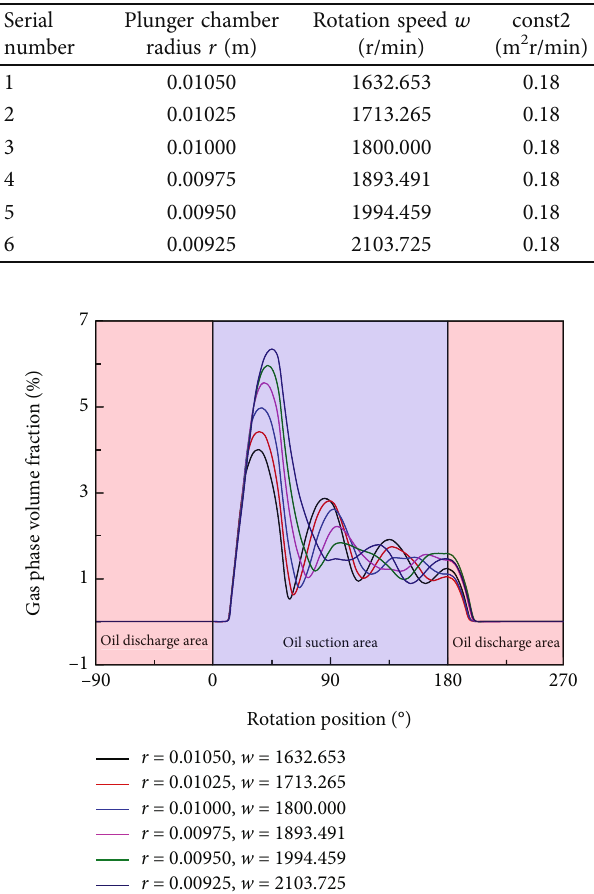
Figure 17: The curves of the gas phase volume fraction in the plunger chamber with di ff erent plunger chamber radii and rotation speeds.